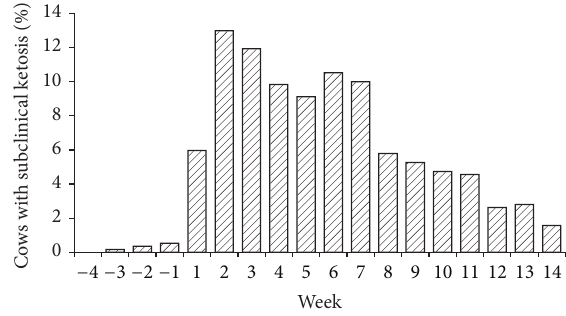
Figure 2: Distribution frequency of subclinical ketosis status (low and moderate ketone bodies excretion: 5–150 mg AcAc/dL) accord- ing to week postpartum.